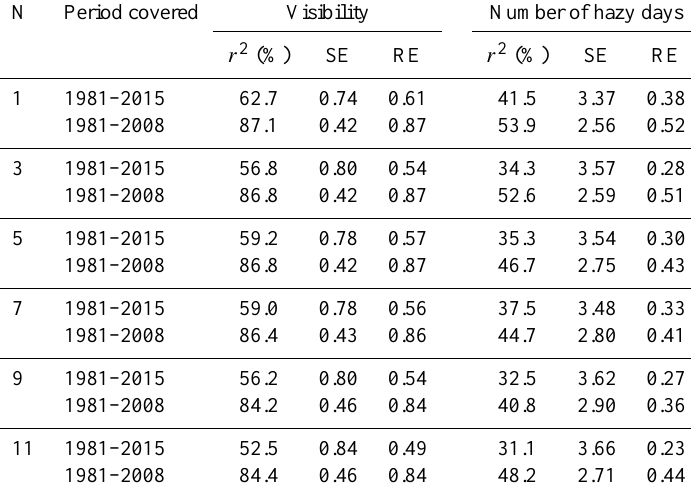
Table 4. List of the statistics for the leave-N-out cross-validation estimations. N Period covered Visibility